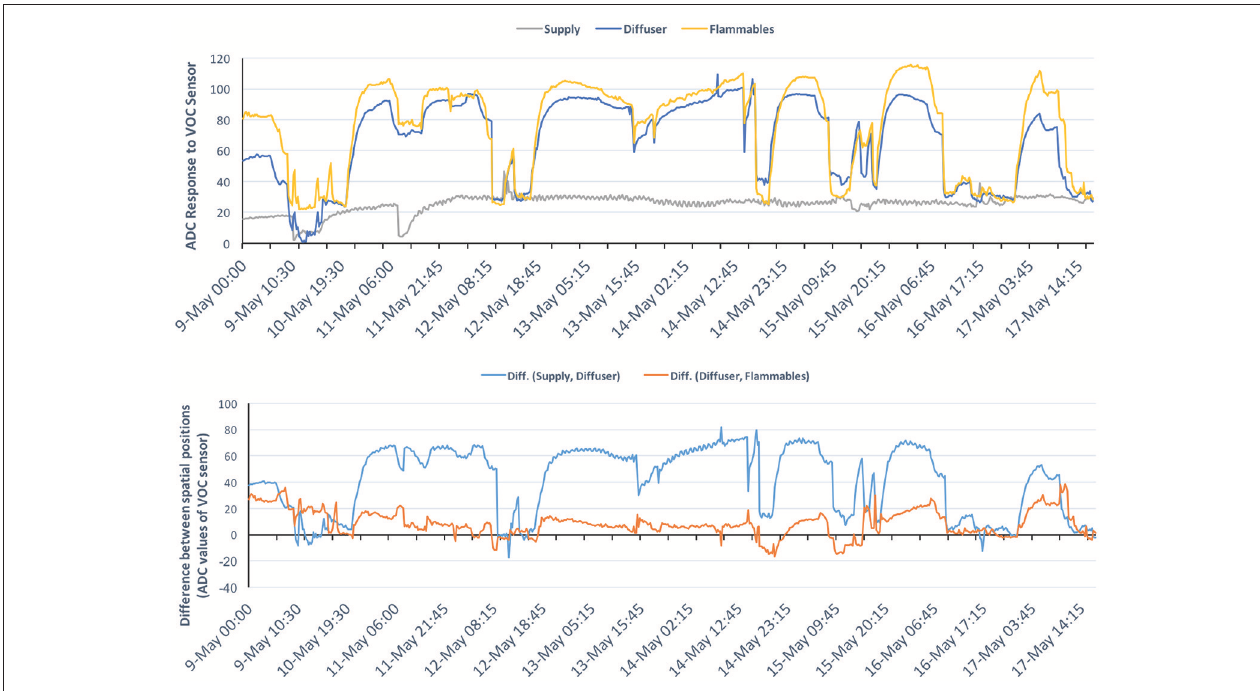
TABLE 2 | Summary statistics from the uncalibrated and calibrated sensor signals, during the calibration experiment. Signal Uncalibrated Calibrated % Reduction Parameter Ave. spread Ave. st. Dev Ave. CI Ave. spread